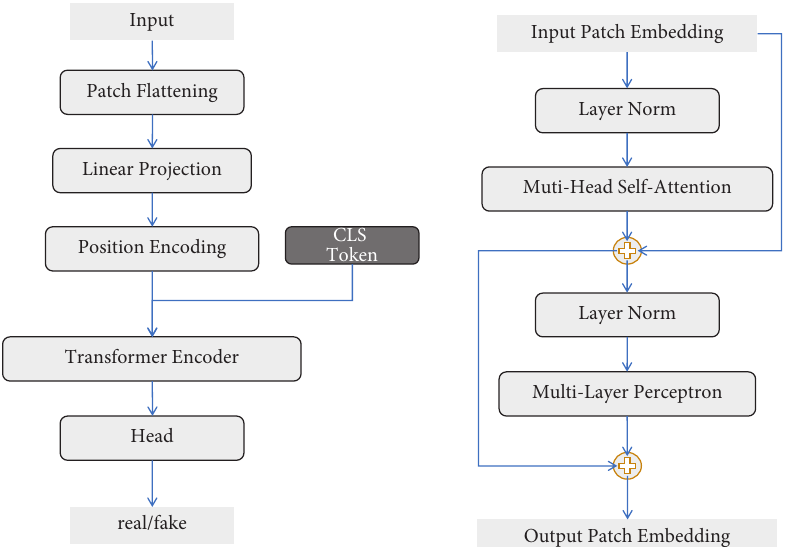
Figure 2: Detailed chart of global discriminator. The left side shows the overall computational flow of the global discriminator, and the right side shows the details of the transformer encoder on the